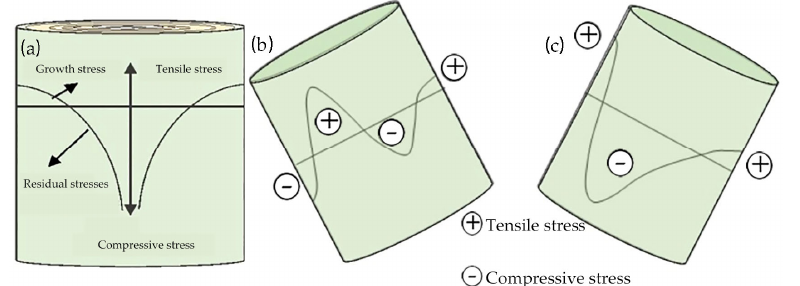
Figure 1. Distributions of longitudinal growth stress and residual stress from pith outwards in trunks [18]: ( a ) normal wood with symmetrical growth stress; ( b ) compression wood on the lower face with longitudinal compressive stress; ( c ) tension wood on the upper face with longitudinal tensile stress.